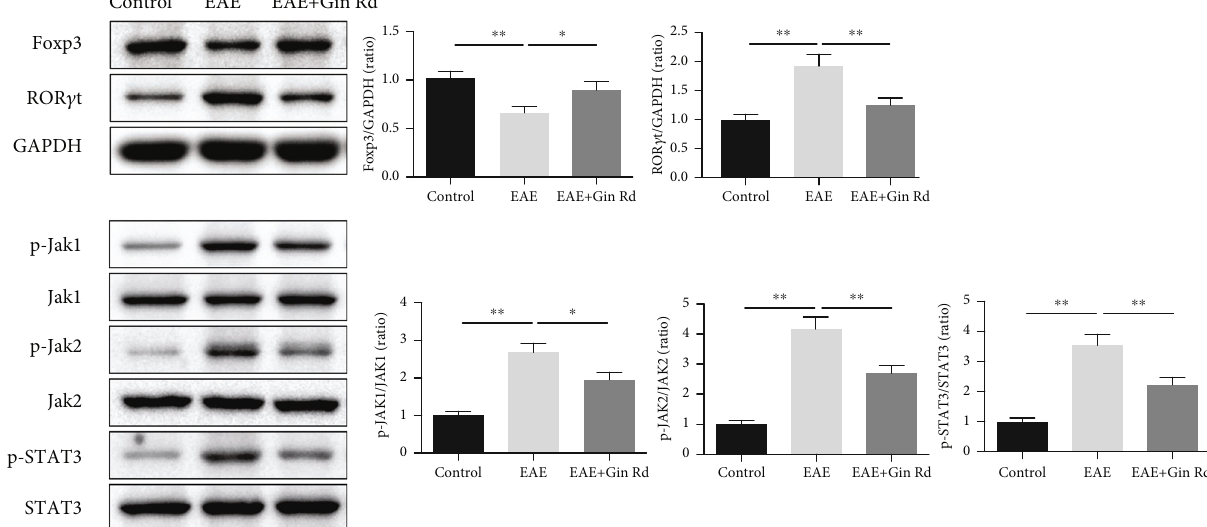
Figure 6: Relative protein expressions of Foxp3, ROR γ t, p-JAK1, JAK1, p-JAK2, JAK2, p-STAT3, and STAT3 in the spinal cord of EAE mice using western blotting assay ( n = 3 ). GAPDH was used as the internal control. Data are expressed as the mean ± SD for each group ( n = 3 ). ∗ P < 0 : 05 , ∗∗ P < 0 : 01 vs. EAE group. Gin Rd: Ginsenoside